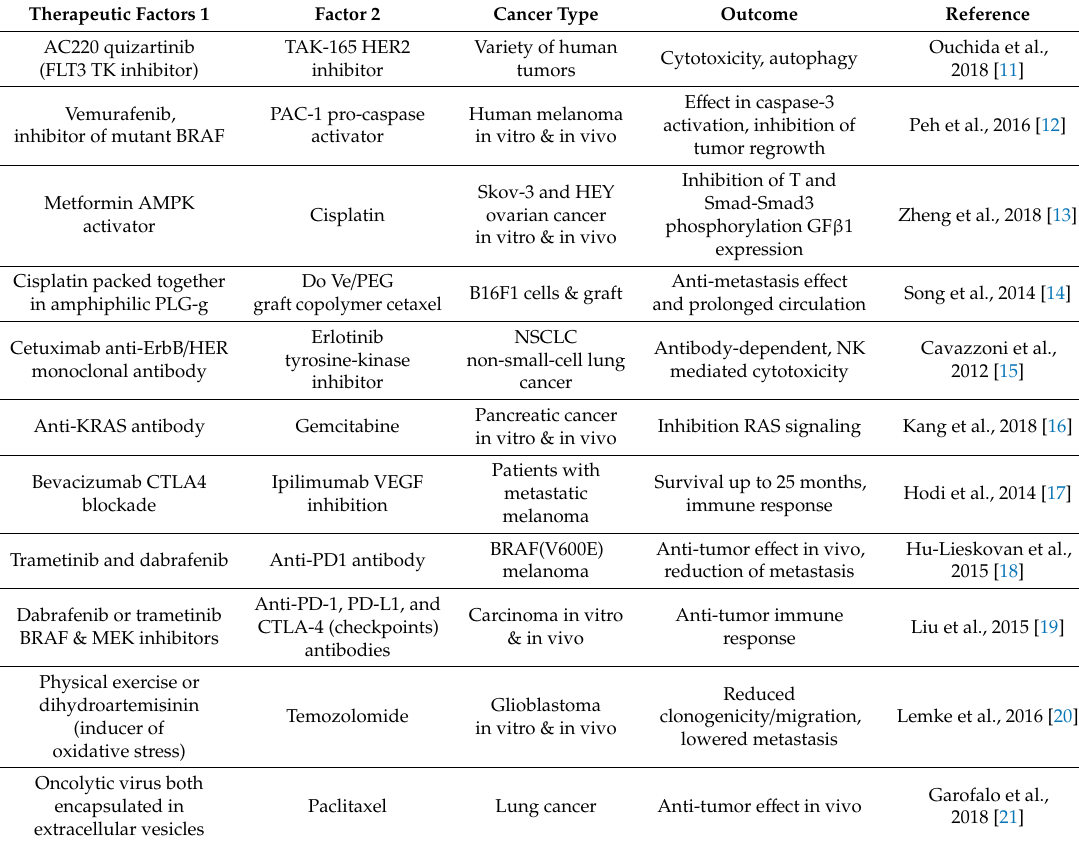
Table 1. Combinatorial anti-tumor